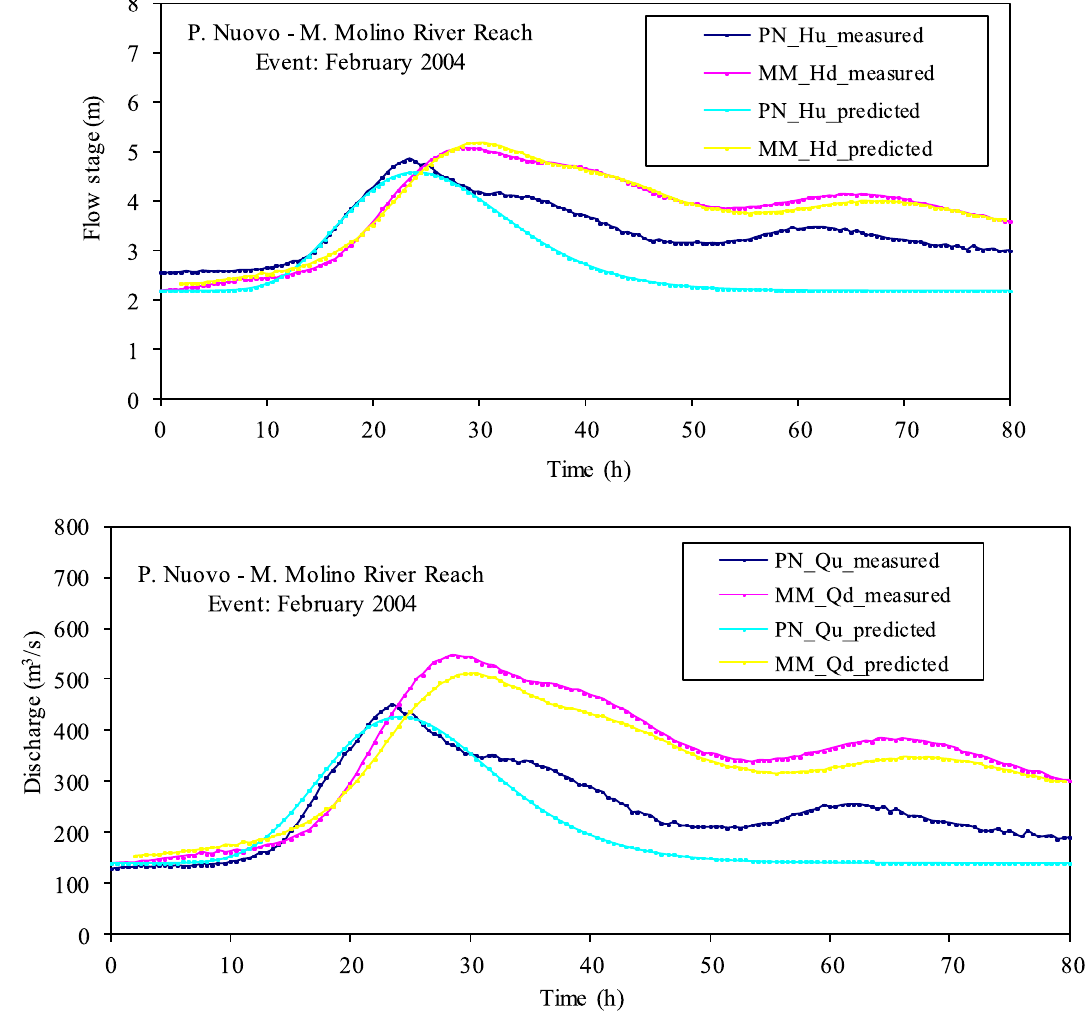
Fig. 9 Flow stage (above) and flow discharge (below) hydrograph simulations for event February 2004 in P. Nuovo and M. Molino river